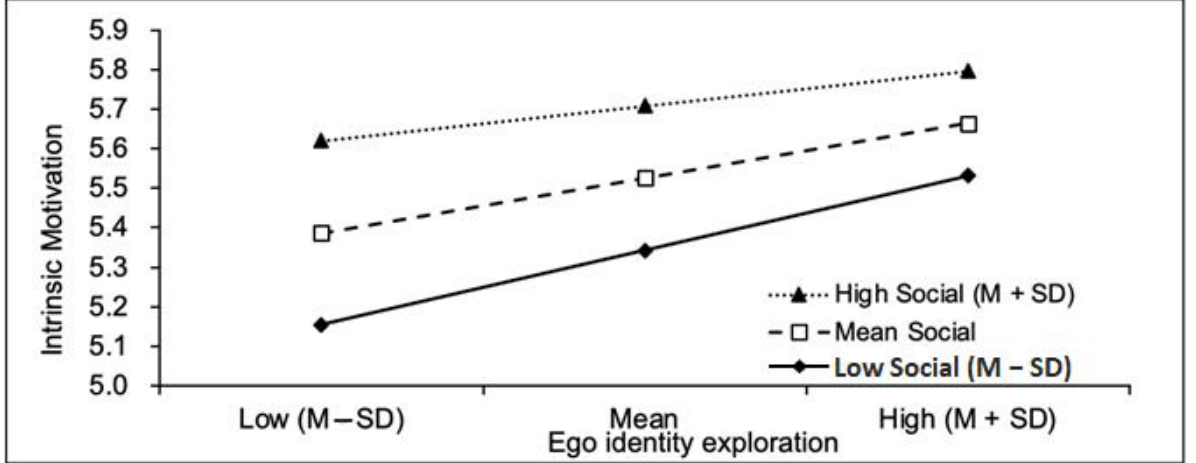
Figure 2. Simple slope analyses of the moderating effect of social